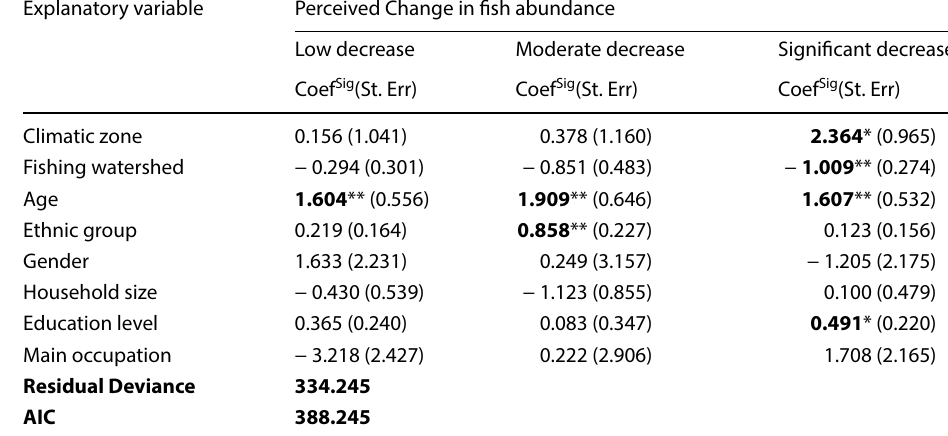
Table 8 Results of multinomial logistic regression of socio- demographic factors influencing Ivorian fishermen’s perception of change in fish